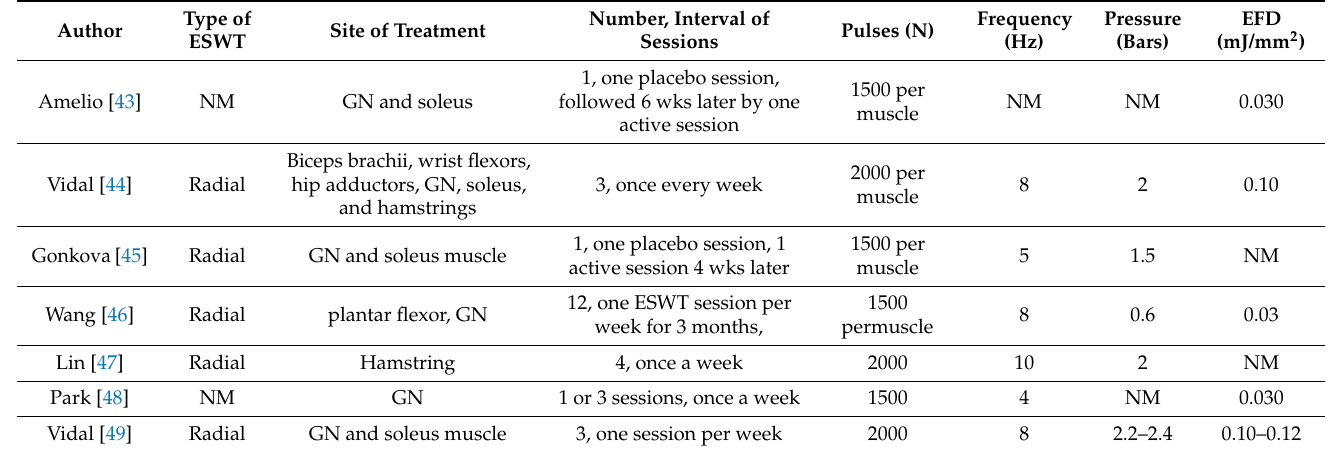
Table 6. Cerebral palsy studies-ESWT